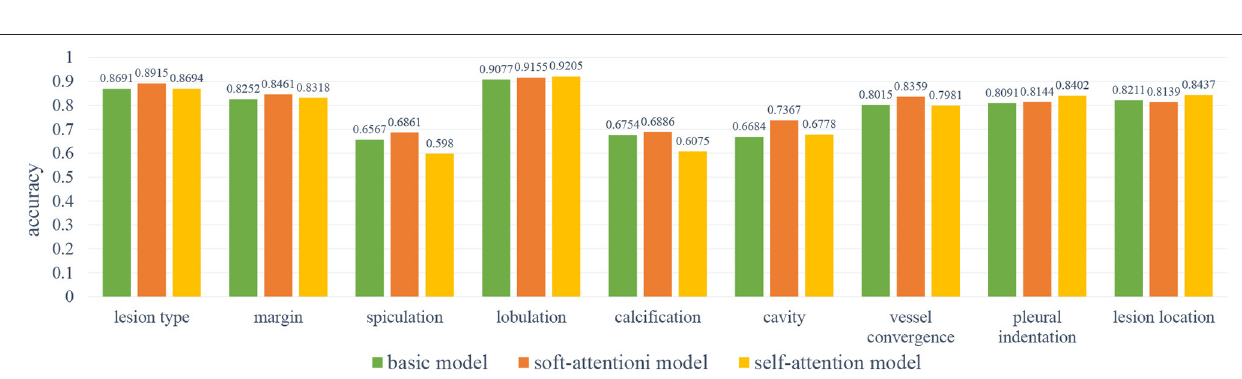
Frontiers in Digital Health |